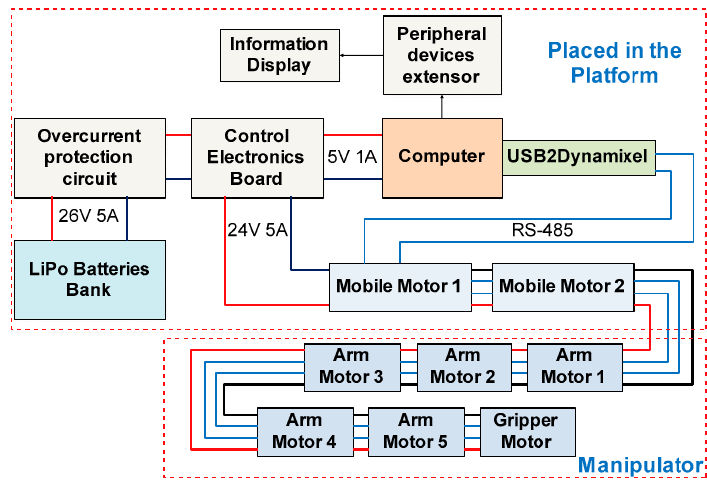
Figure 8. Electronic design of the components of the robotic system.